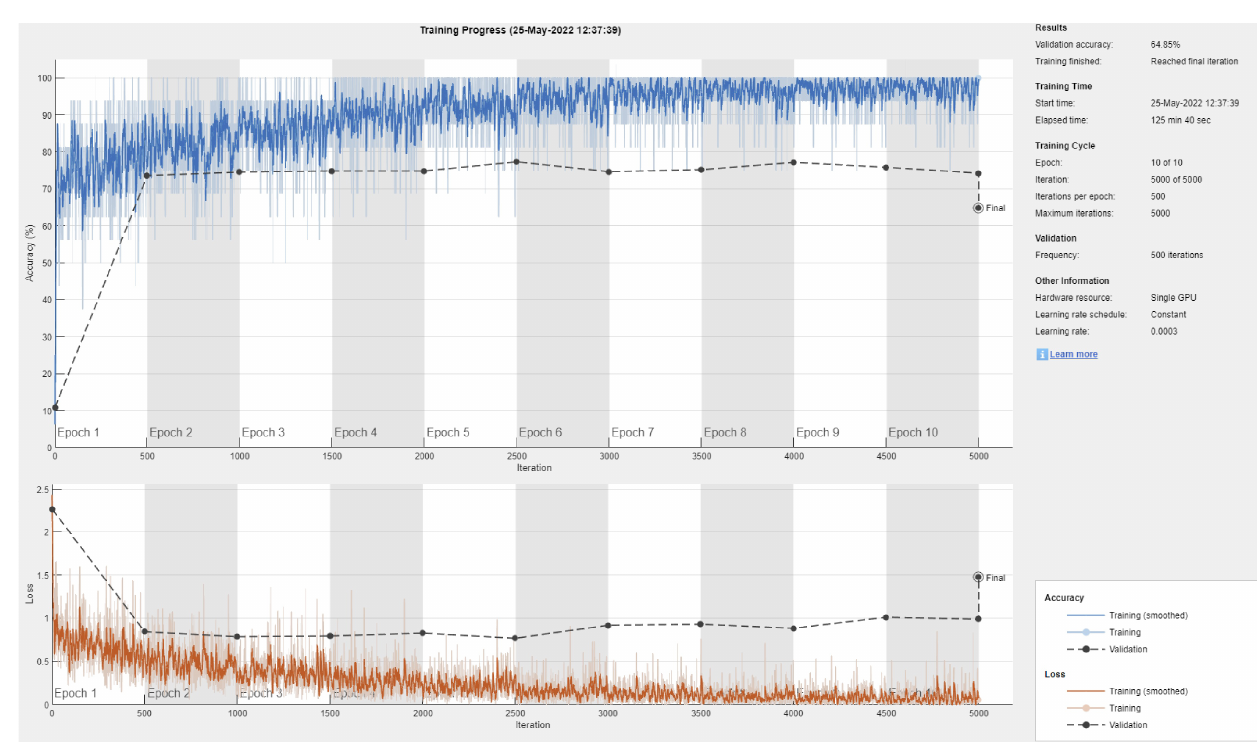
Figure 5. Sample training/validation progress curve for DenseNet201 and 80/20 data split.